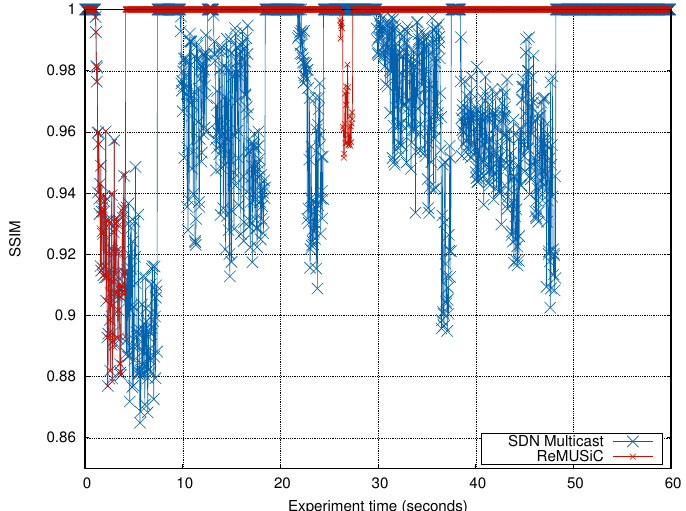
Figure 15. SSIM impact in both ReMUSiC and SDN Multicast